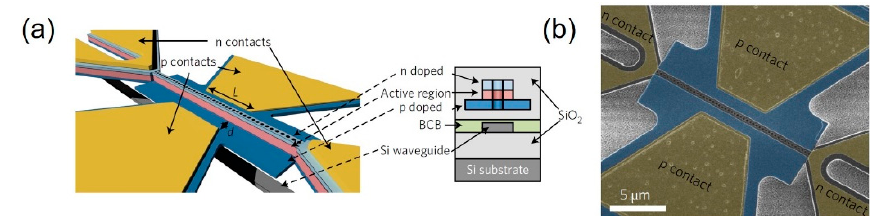
Figure 12. Heterogeneous integration of electrically driven nanobeam lasers with SOI waveguides. ( a ) Schematic illustration of an InP-based electrically driven PhC nanobeam laser heterogeneously bonded on top of an SOI waveguide. Cross-sectional schematic shows device configuration, material composition, and doping profile (inset). ( b ) SEM image of the fabricated nanobeam laser diode after n - and p -type contact metallization and before SiO 2 passivation [50]. Figure reproduced with permission from Springer Nature